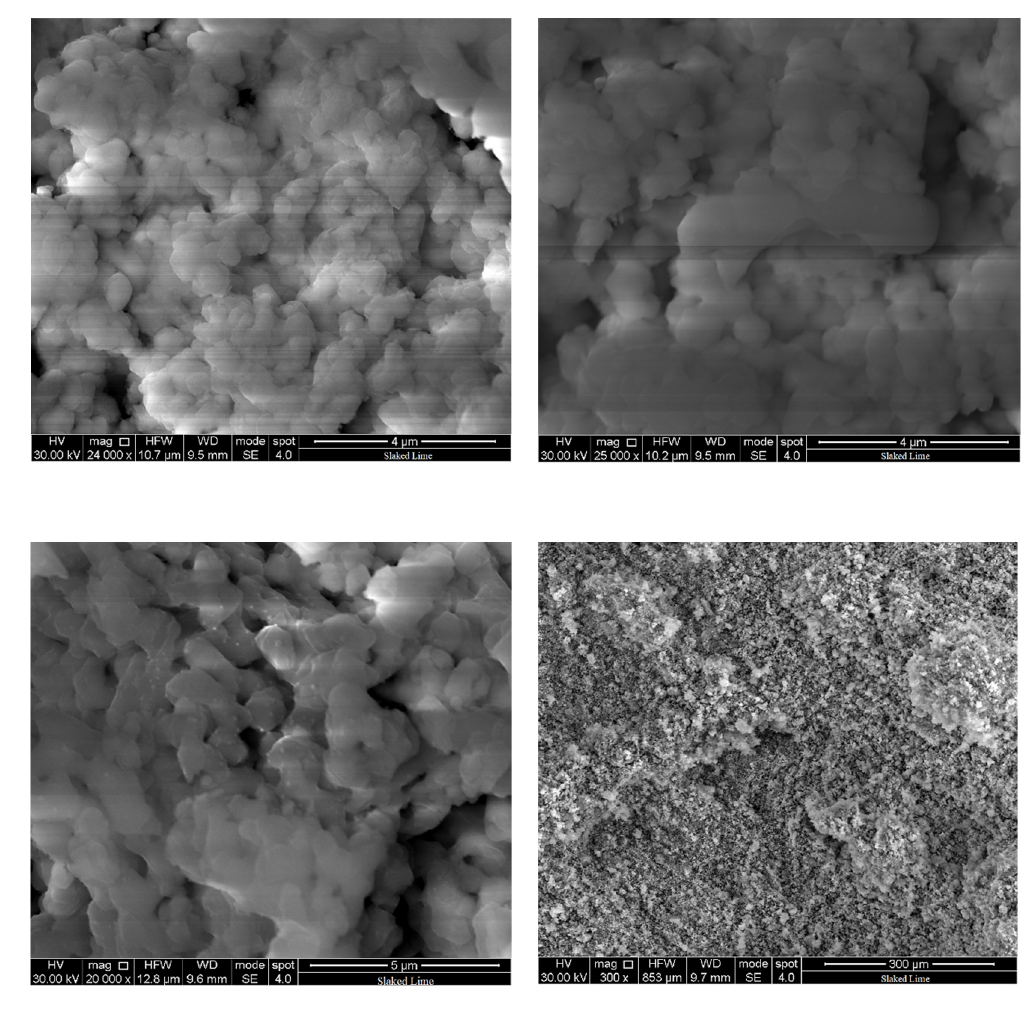
Figure 8. SEM micrographs of slaked lime. Table 2. Composition by volume of the mortars: a = lower than 125 µ m, b = 125 ÷ 210 µ m; c = 210 ÷ 350 µ m. Type of